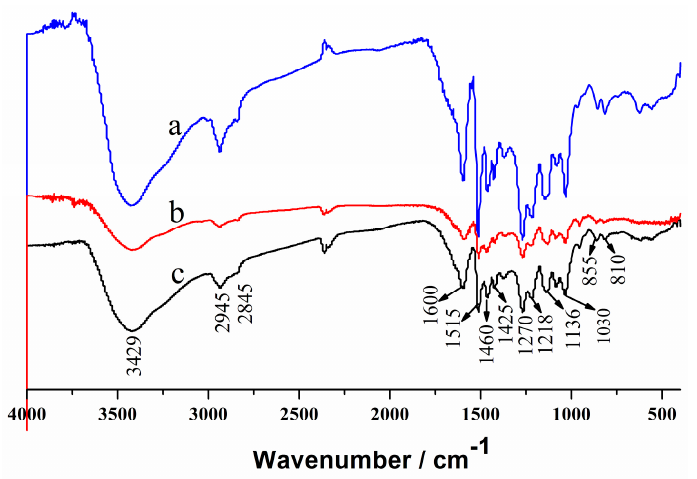
Figure 2. FT-IR spectra of lignin: ( a ) the original lignin; ( b ) the regenerated lignin from [Ch][Fa]/H 2 O ( R = 10:1)/lignin solution; ( c ) the regenerated lignin from [Ch][Na] ( R = 8:1)/H 2 O/lignin solution.